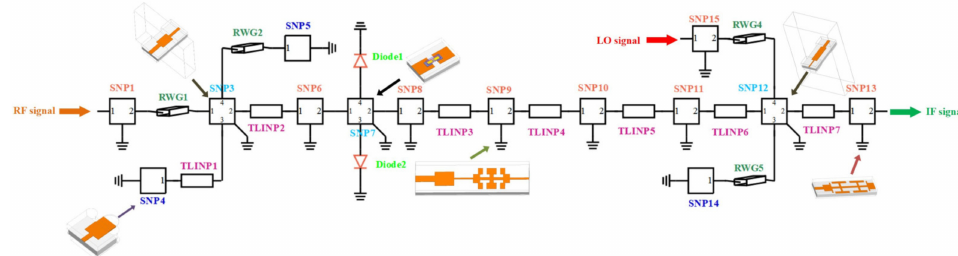
Figure 2. The active circuit model of mixers combining single stage reduced matching technology with the